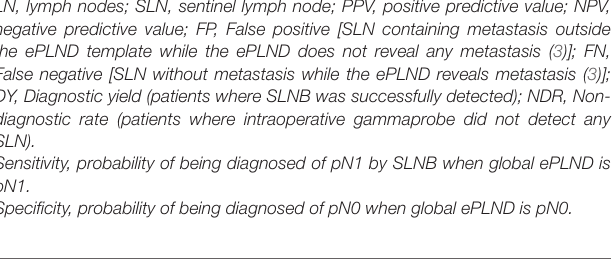
TABLE 4 | Topographic association between radiotracer side injection and SLN side